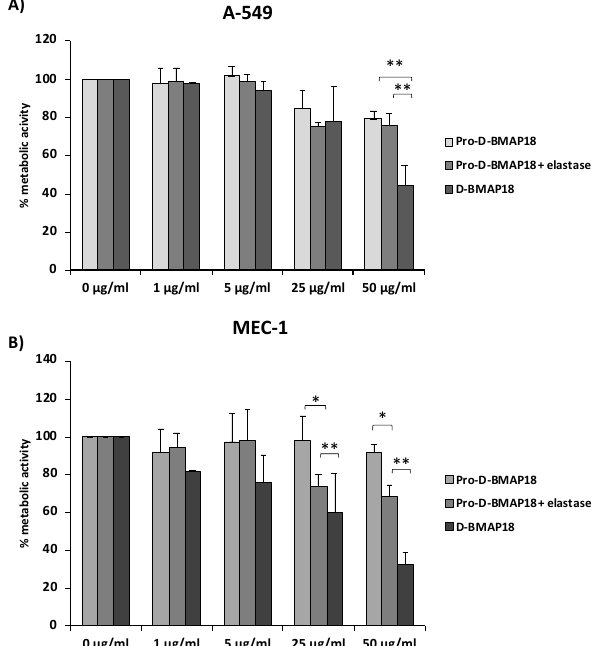
Figure 2. Cell viability assay in the presence of NE-activated Pro-D-BMAP18. An MTT assay was performed using ( A ) adenocarcinomic human alveolar basal epithelial cells A-549 and ( B ) B-chronic lymphocytic leukaemia cells MEC-1. The percentages shown are of metabolically active cells compared with untreated controls after 24 h incubation with different concentrations of Pro-D-BMAP18 with or without NE and D-BMAP18. Results of three different experiments in internal triplicate (n = 9). * = p < 0.05; ** = p < 0.01. A Student’s n = of the treatments vs. the untreated control is reported.